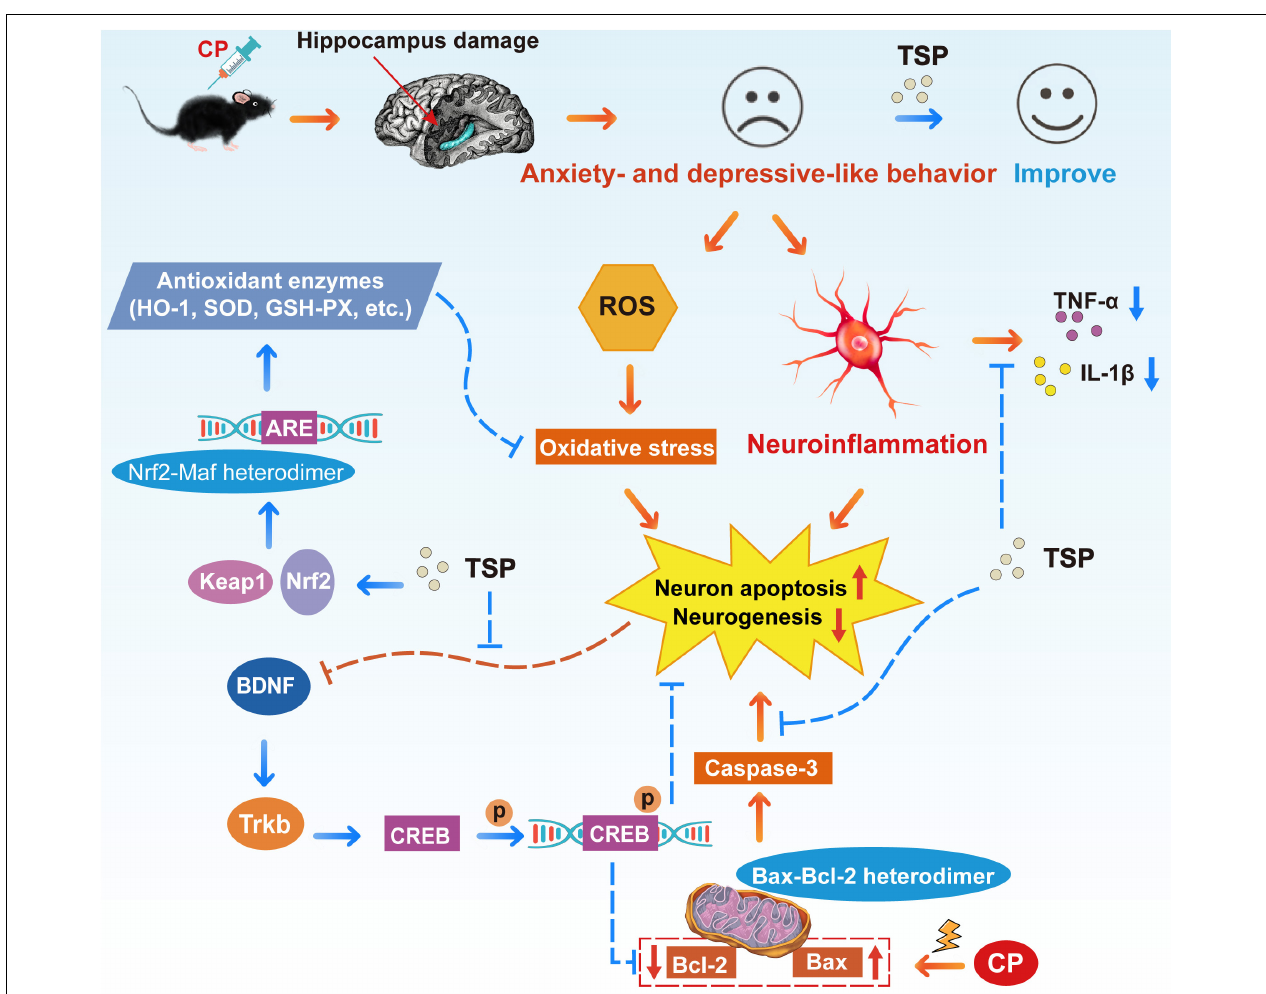
FIGURE 10 | Schematic representation of TSP improving CP-induced anxiety- and depression-like